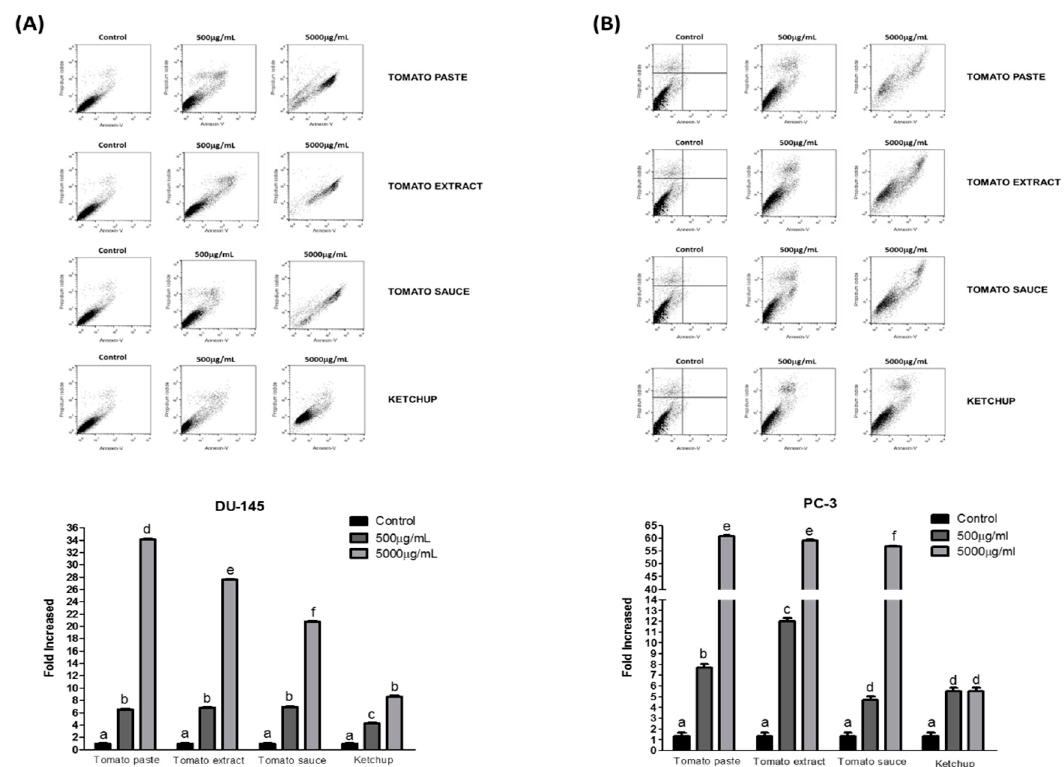
Figure 5. The effect of lycopene obtained from tomato paste, tomato extract, tomato sauce and ketchup in the process of programmed death in DU-145 ( A ) and PC-3 ( B ) cells the after 96 h treatment. The flow cytometric analyses are shown according to the exposure time and carotenoid concentration. The quantitative results of lycopene on cell lines are shown after 96 h. The data are expressed as mean ± standard error. Variation in the letters between samples indicates significance difference ( p < 0.05).